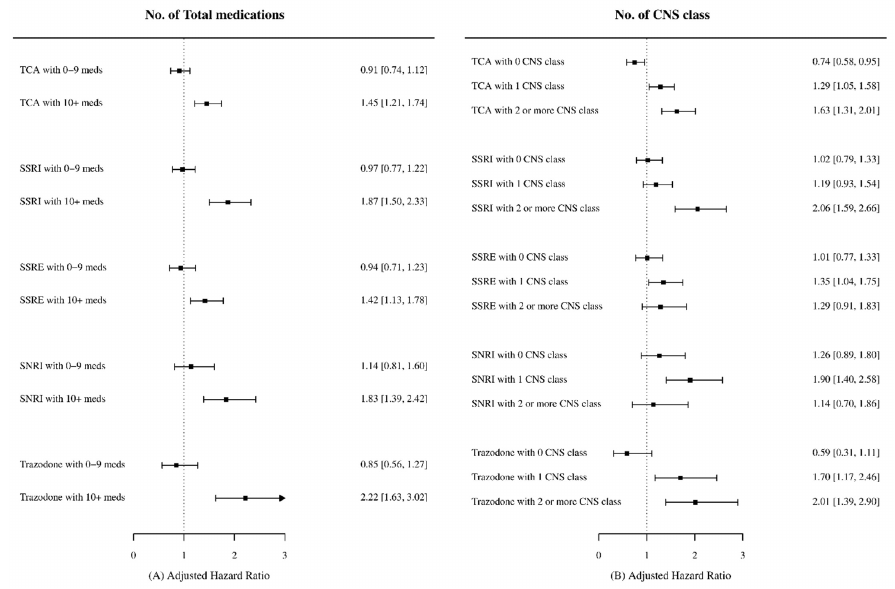
Figure 3. The subgroup analyses of antidepressant classes by ( A ) the number of total medications and ( B ) the CNS class associated with fall-related injuries.